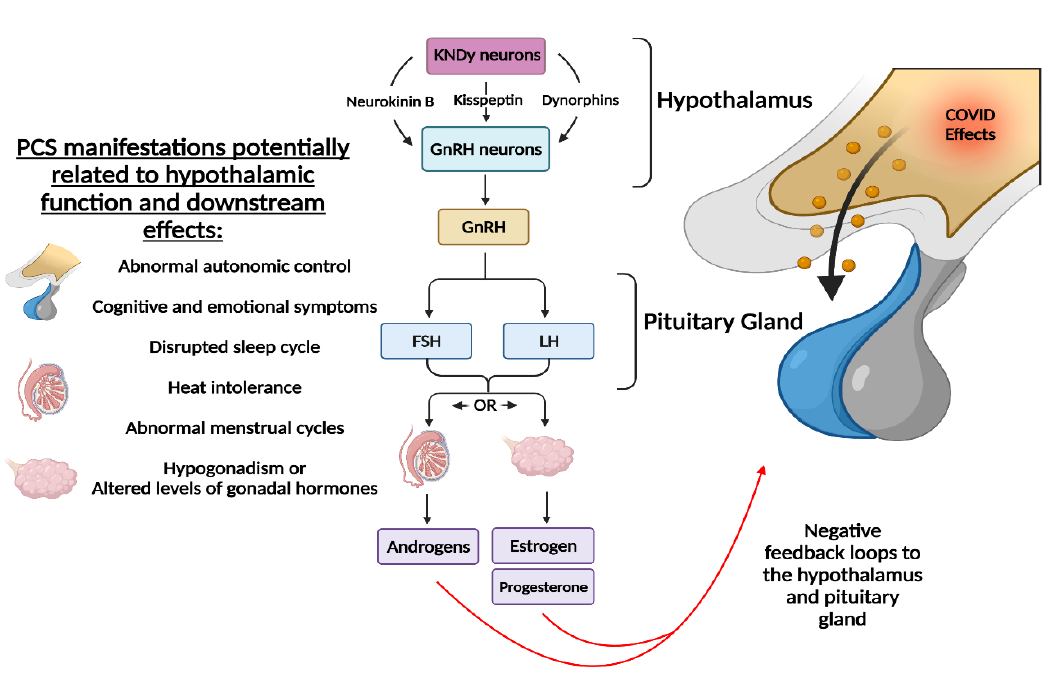
Figure 5. The hypothalamic circuit as a hub for PCS development: A plethora of PCS symptoms might be due to a disruption of key hypothalamic functions [117,120]. The KNDy hypothalamic neurons in the POA and ARC hypothalamic regions are vital for maintaining thermoregulation and reproductive health [93]. KNDy neurons are key regulators of GnRH release [99,100] and HPG axis homeostasis. COVID-19 illness due to viral invasion and/or the subsequent hyperinflammatory state may alter KNDy neurons and contribute to the heat intolerance, altered gonadal hormones, and abnormal menstrual cycle noted in PCS [18,104,106]. Furthermore, the paraventricular nucleus (PVN) of the hypothalamus plays a vital role in maintaining autonomic homeostasis and neurocognitive functions [118,120], which might be compromised in PCS, and might explain the neurological sequelae in PCS [8,9,24]. Figure was created with the BioRender software.